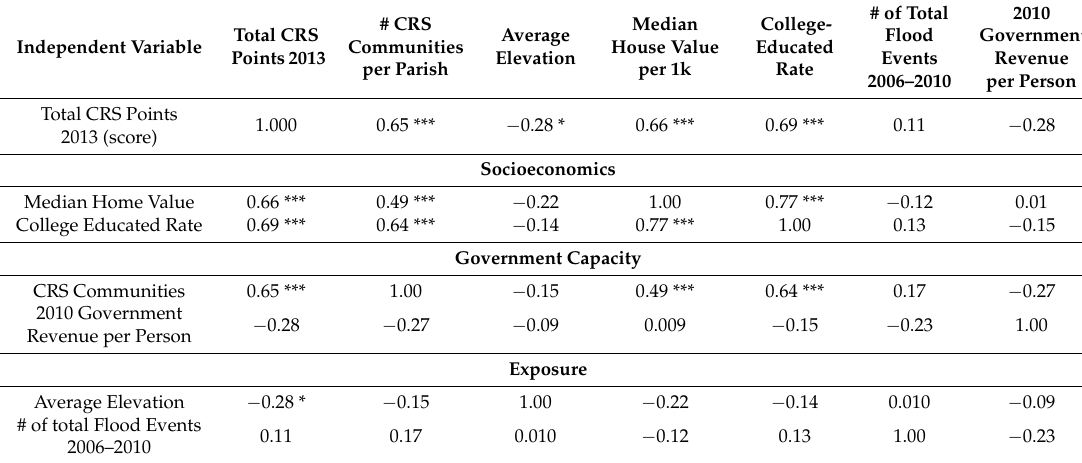
Table 6. Pearson correlation analysis.